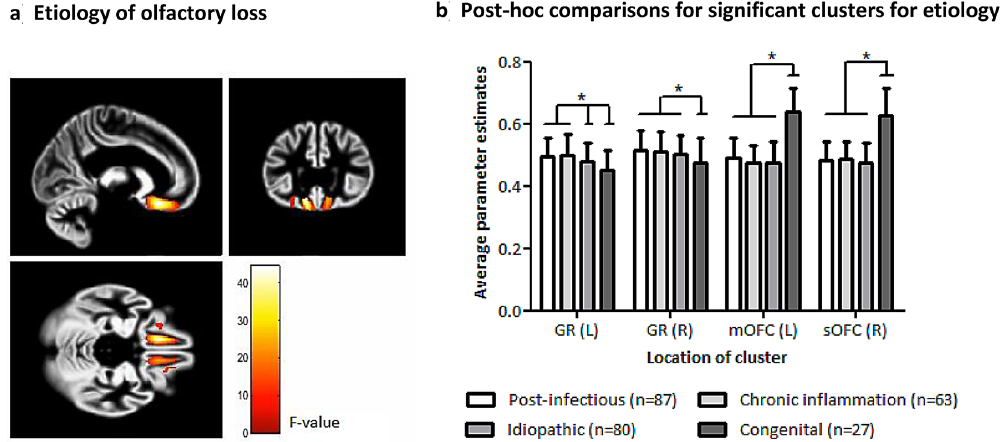
Figure 1. ( a ) Main effect of etiology group on ROI gray matter volume in the gyrus rectus (GR) and medial and superior orbitofrontal cortex (mOFC; sOFC), reported at p < 0.05 (FWE); results are shown as F-map overlaid